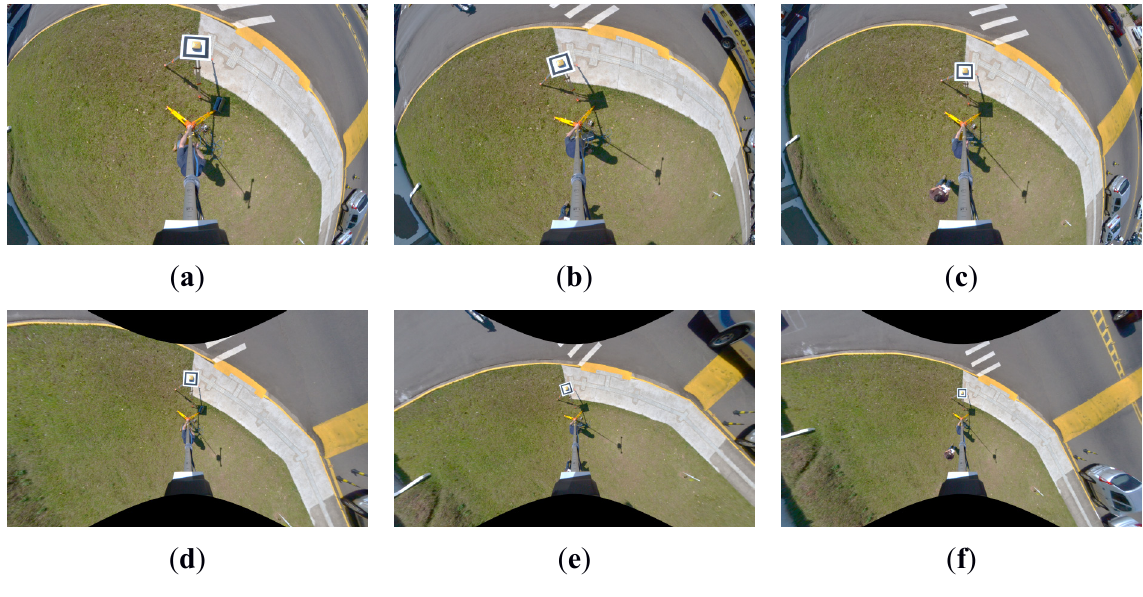
Figure 9. Multi-scale models with original images from ( a – c ) and resampled images from ( d – f